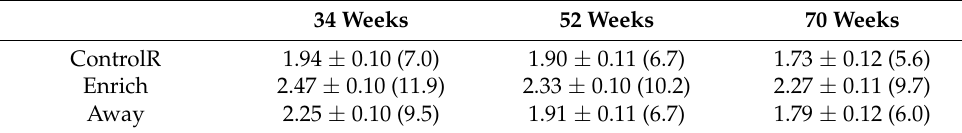
Table 5. Mean ± SE log (total counts of birds) (back-transformed shown in parentheses) observed over all behaviours by age (34, 52, and 70 weeks) and location (ControlR, Enrich, Away), estimated from GLMM.